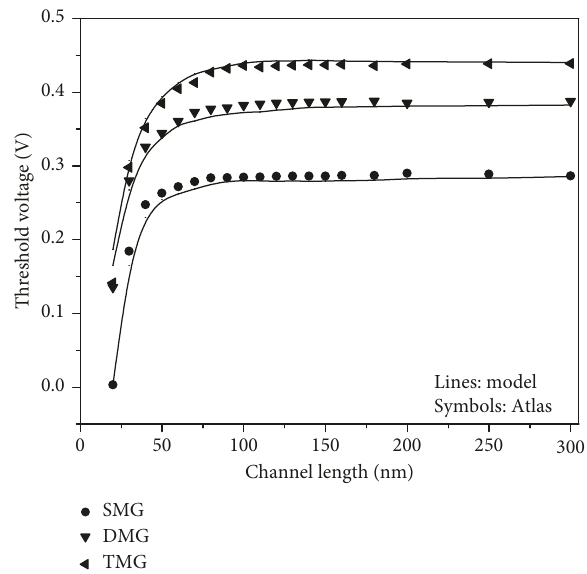
Figure 2: Comparison of threshold voltage for SMG, DMG, and TMG Re-S/D SOI MOSFET